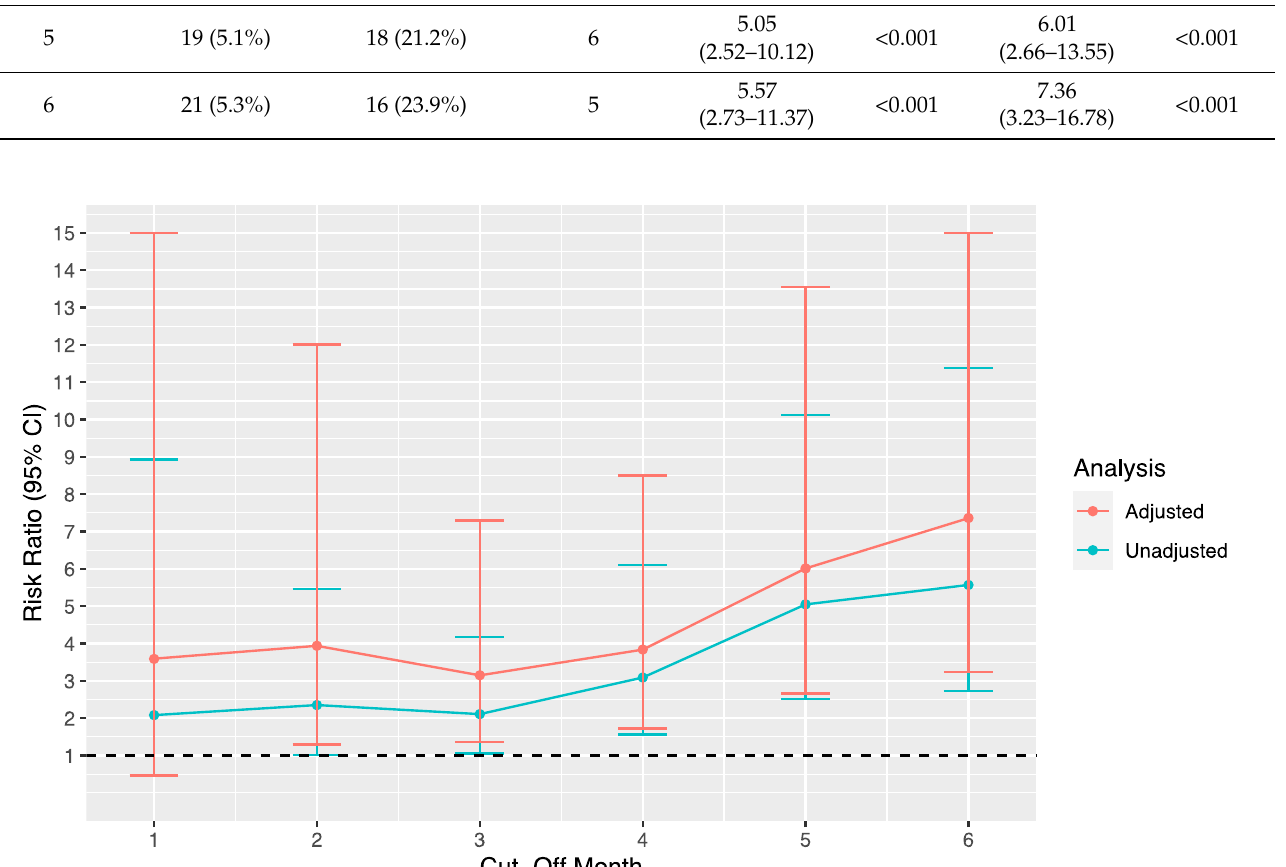
Table 2. Risk of post-ureteroscopic febrile UTI. Adjustments for age, sex, maximum stone diameter, operative time, positive pre-operative urine culture and stone free status. RR = Risk ratio, CI = con- fidence interval. Significance level = 0.0306.